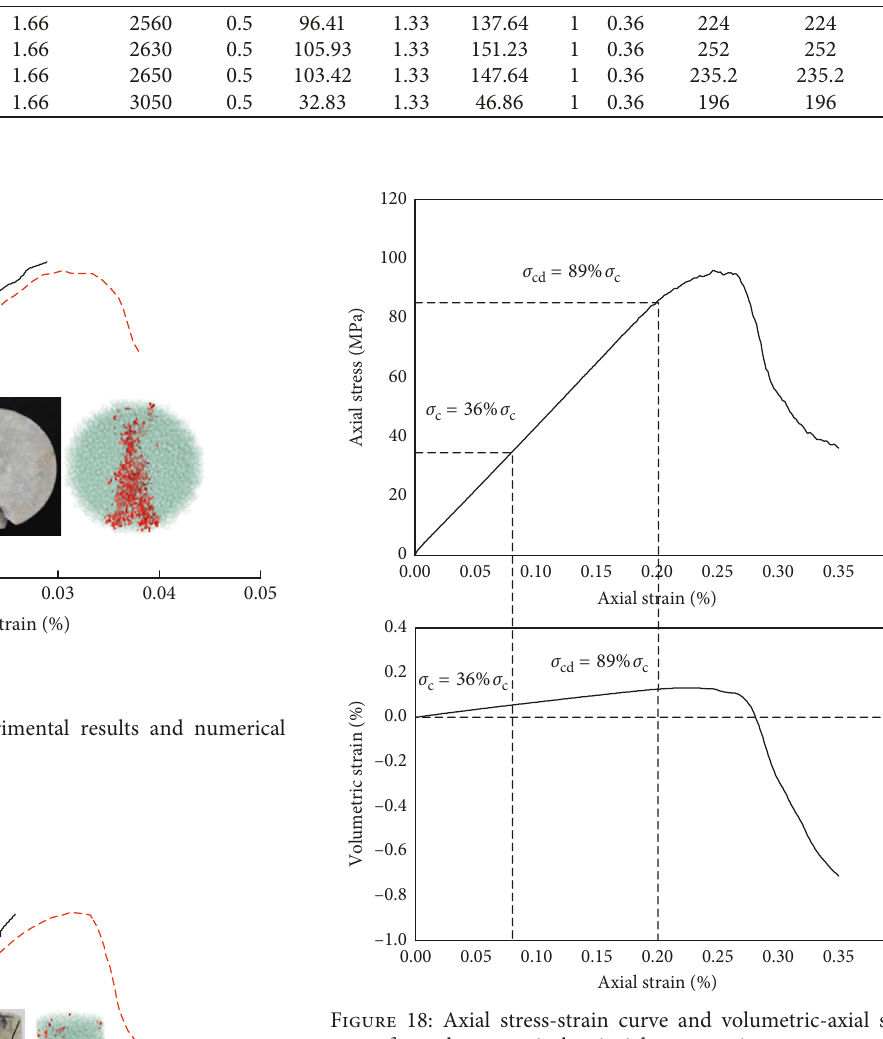
Table 4: Microparameters of the multicomponent bonded-particle model after performing calibration. Mineral